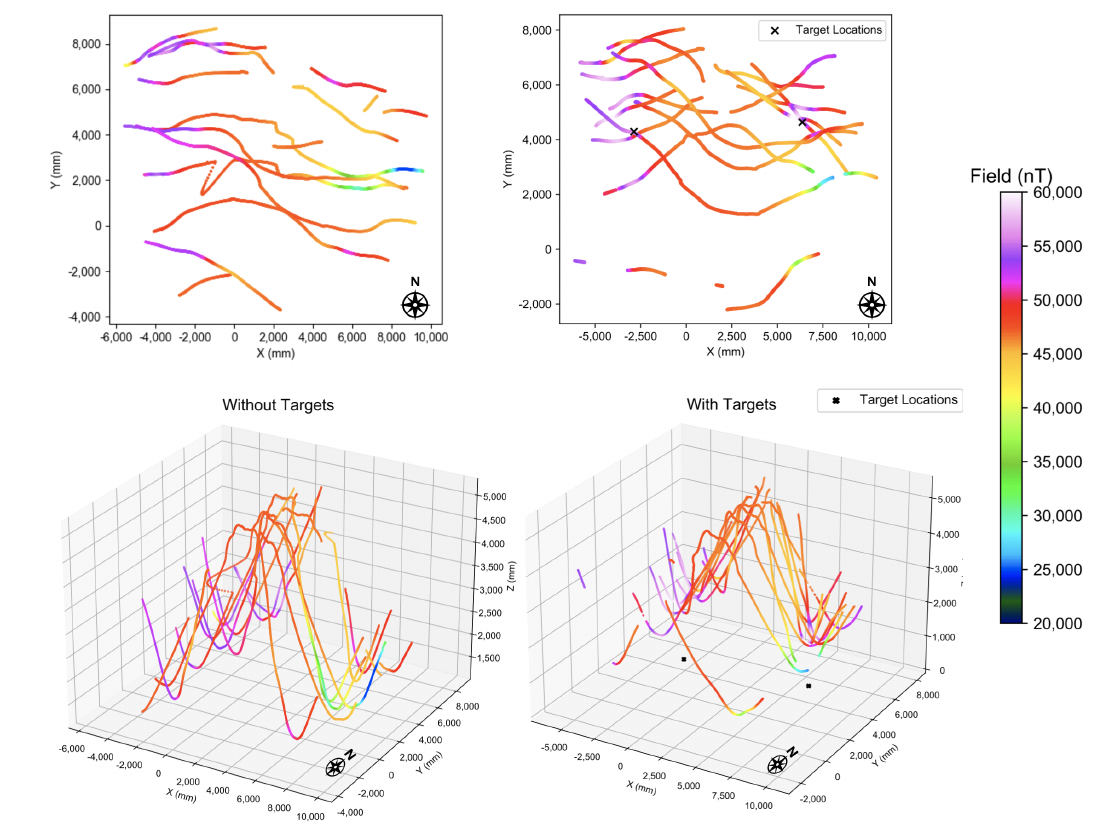
Figure 5. Glider trajectory for background and experimental tracks, colored according to scalar total field. Magnetic targets were installed at the dark points on the bottom of the pool. The experimental analysis focuses on the target on the right